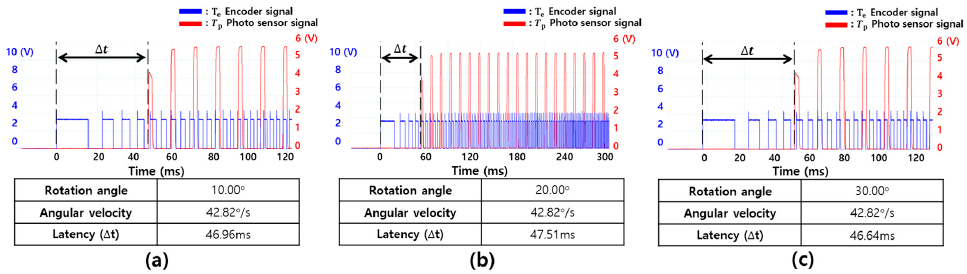
Figure 15. Latency measurement results when the pitch rotation angle was changed: ( a ) 10 ◦ , ( b ) 20 ◦ , and ( c ) 30 ◦